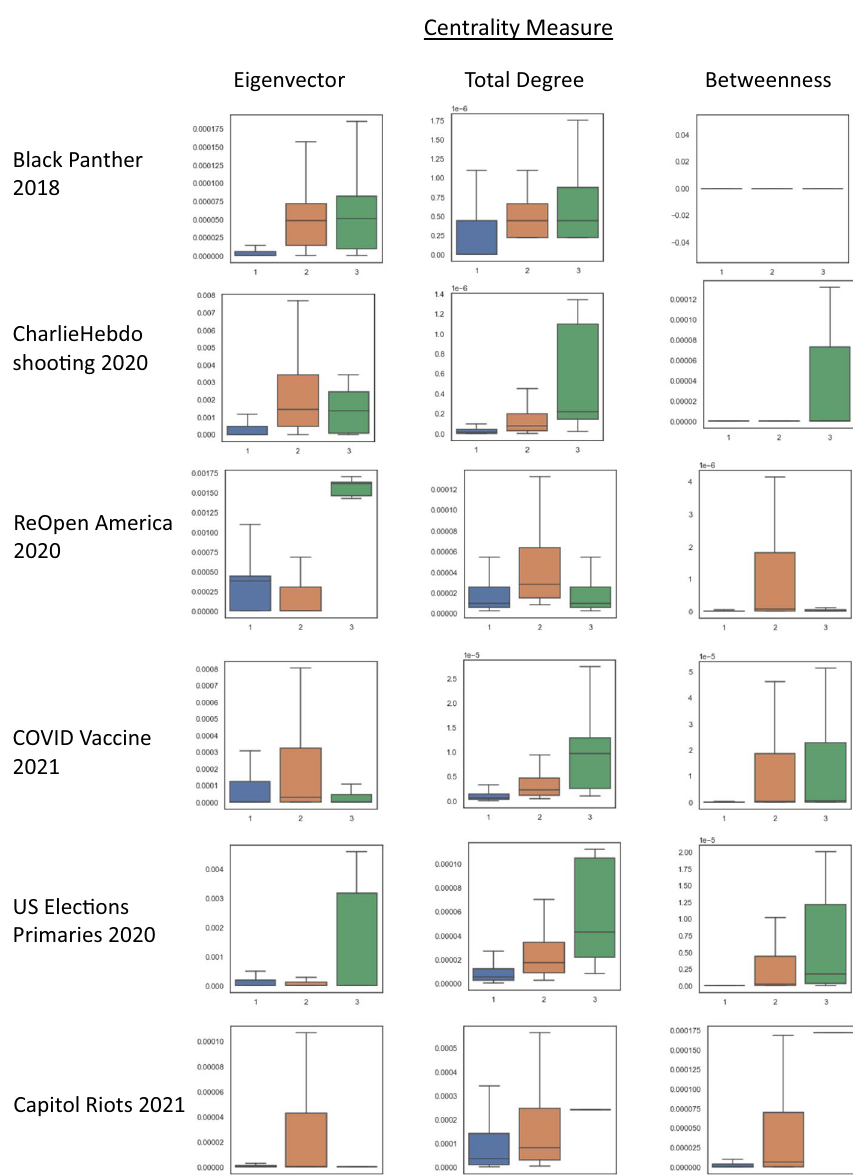
Fig. 2 Analyzing user pairs with network centrality measures. Boxplot representations of network centrality measures against the number of action types users coordinate across. These graphs represent user-to-user all-communication